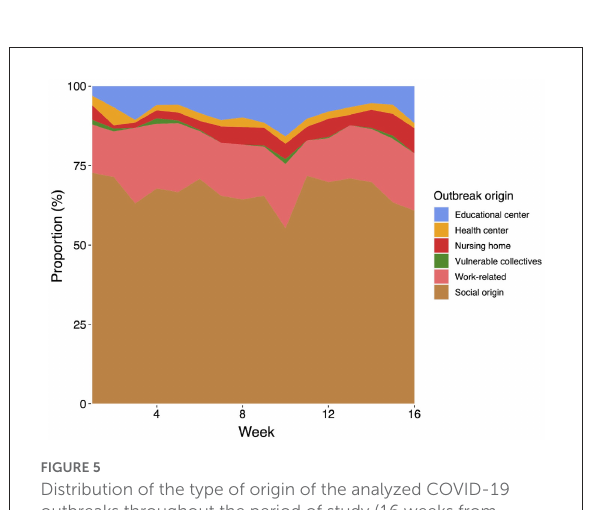
FIGURE6 Temporal evolution of the proportion of confirmed cases linked to an outbreak vs. the total number of confirmed COVID-19 infections and its linear